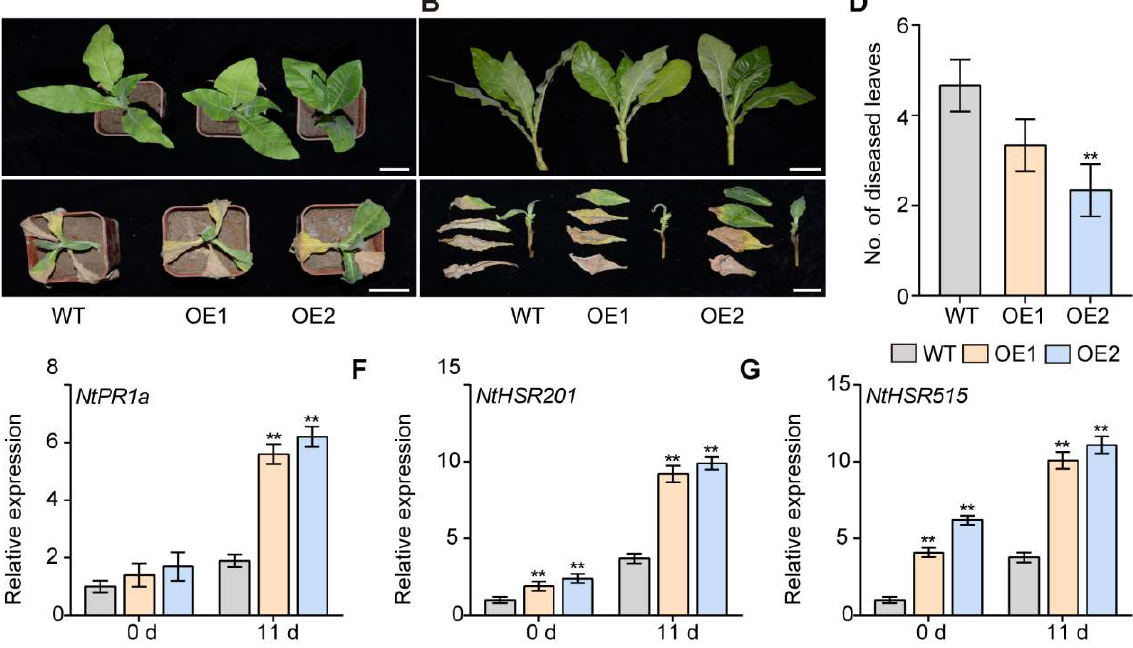
NtHSR201 and NtHSR515 after Fob infection in transgenic plants (Figure 11E–G). Over- all, the results suggested that IbPIF3.1 functions as a positive regulator of Fob resistance in